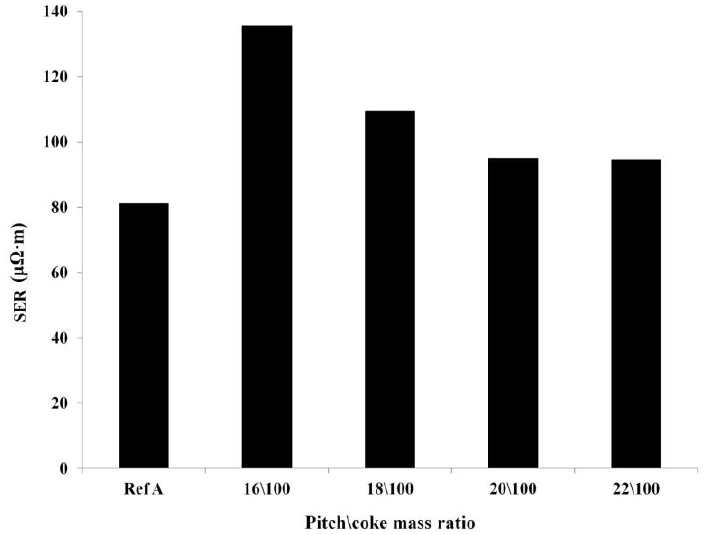
Figure 4. The influence of pitch content on the specific electrical resistivity (SER) of anodes containing 10% charcoal compared to the reference anode (Ref A).